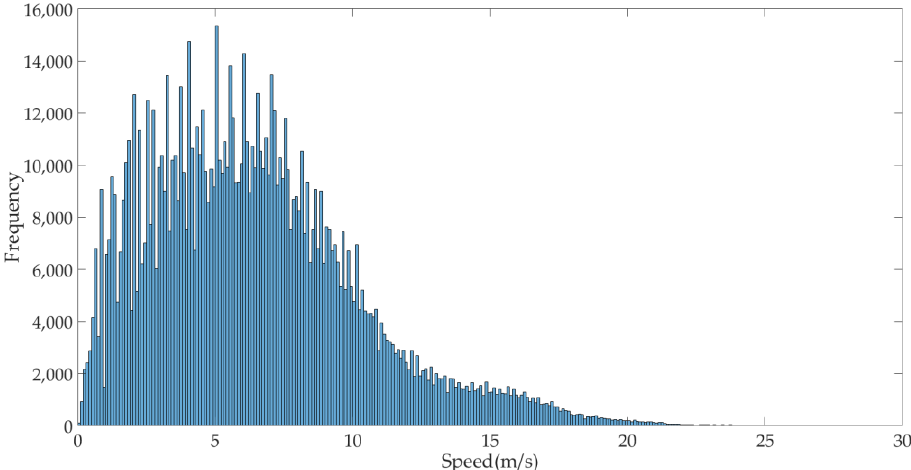
Figure 9. Velocity distribution histogram.